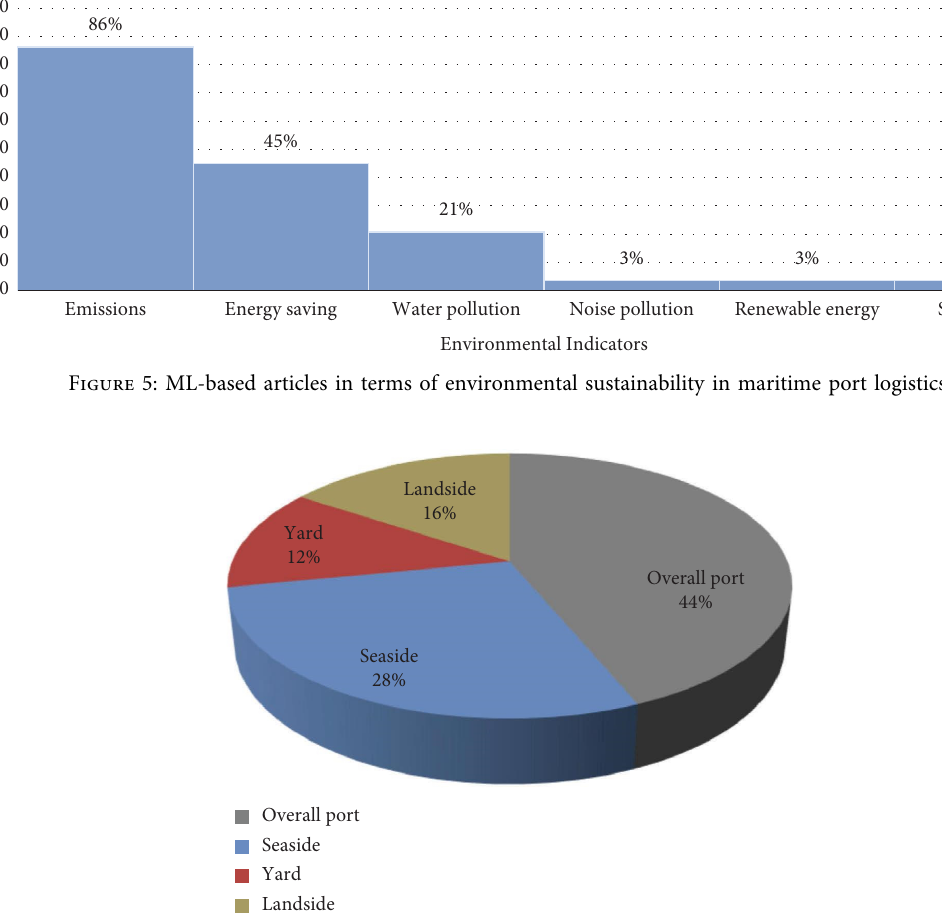
Figure 6: Distribution of selected articles based on application areas within the